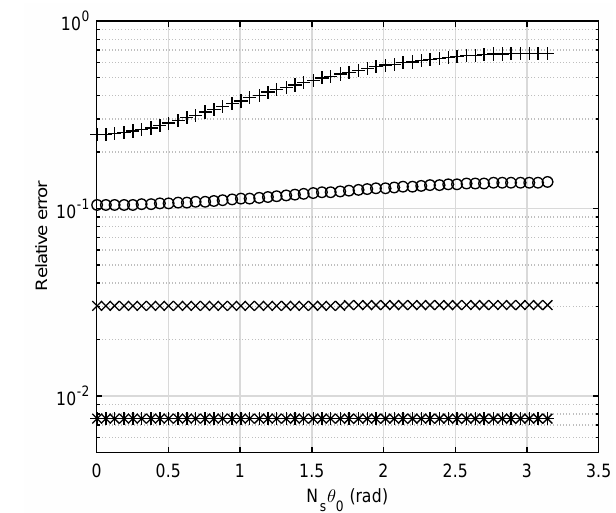
Figure 7. Variation in the straight segment approximation to I 2 c ( θ ) for θ 0 = 0 and N r = 5, × ; 10, ◦ ; 20, (cid:5) ; + , 50; × , 50000. N s = 40, s = 0 .